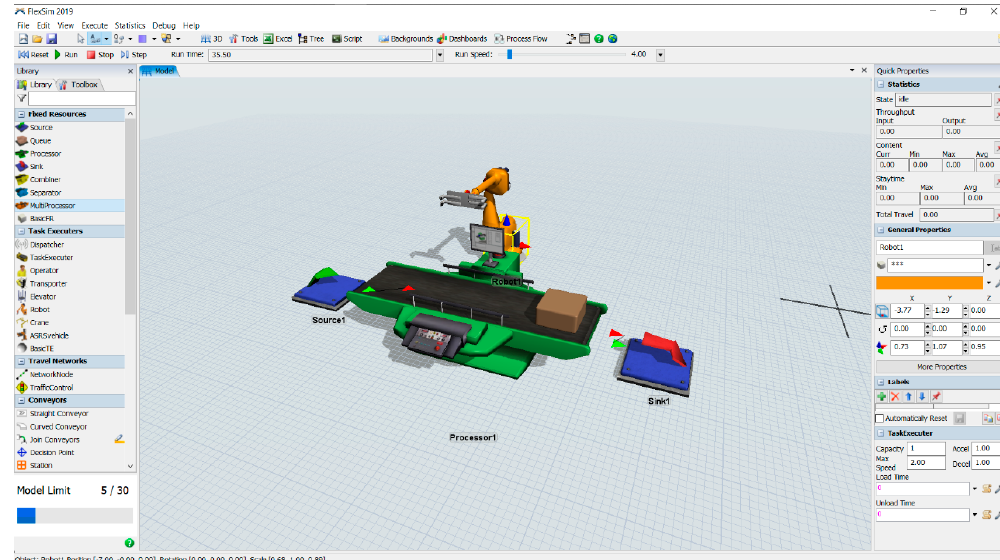
Figure 4. FlexSim environment with a basic model. The construction of the model is based on the selection of the elements that are presented on the left side and the configuration of those elements on the right side of the environment.